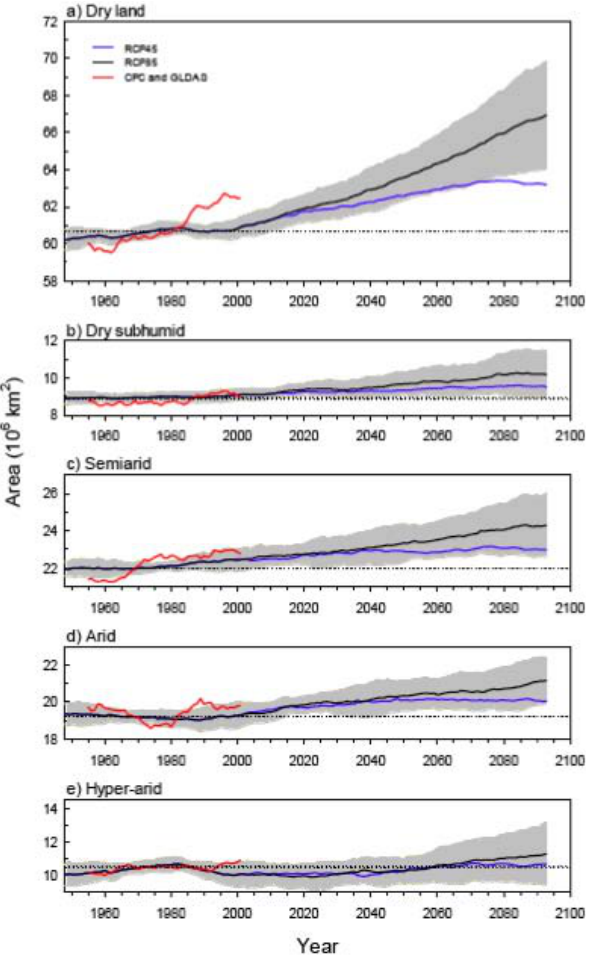
Fig. 3. Temporal variations in areal coverage of global drylands for (a) the total and individual components of (b) dry subhu- mid, (c) semiarid, (d) arid, and (e) hyper-arid regions, in units of 10 6 km 2 . Thick black (blue) lines are the ensemble average of the 27 models from historical/RCP8.5 (RCP4.5) simulations. Dotted line shows the climatology of 1961–1990. The grey shading denotes one standard deviation of the 27 models from historical/RCP8.5 simu- lations. Red lines are for dryland areas based on observational data. A 15yr running smoothing was applied to emphasize the climate change.